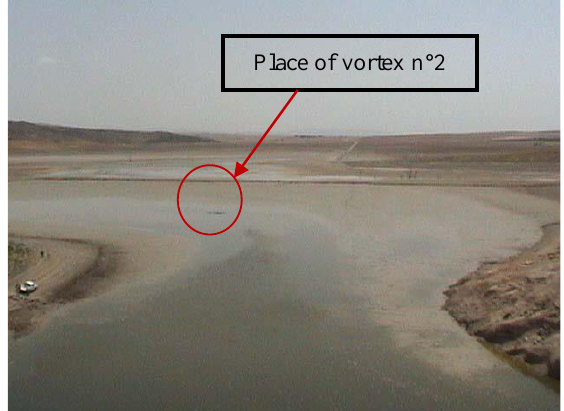
Figure 23. Appearance and location of the vortex n°2 in the lake of Hammam Grouz